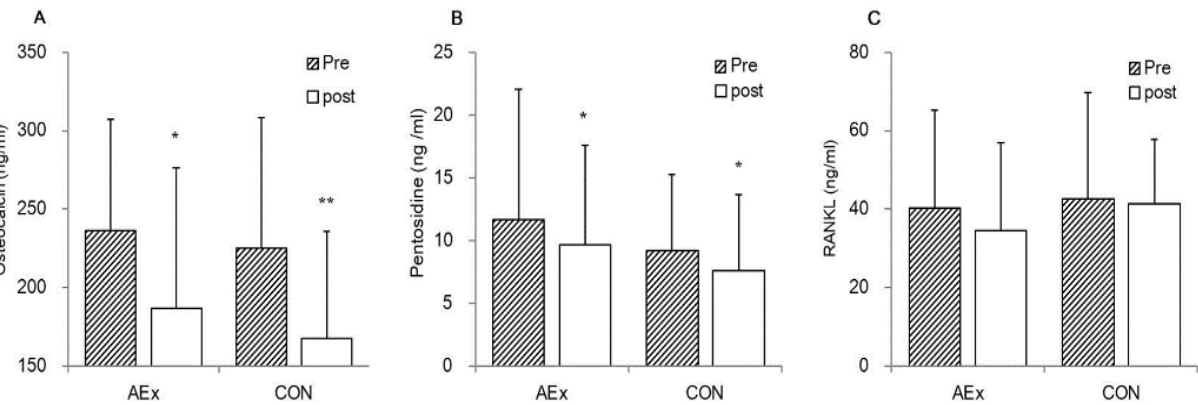
Figure 1. Bone turnover markers in AEx and CON pre-and post-intervention. Note: * p < 0.05, ** p < 0.01, paired t -tests were used to analyze the changes in variables within groups. Data are means ± SD (standard deviation).